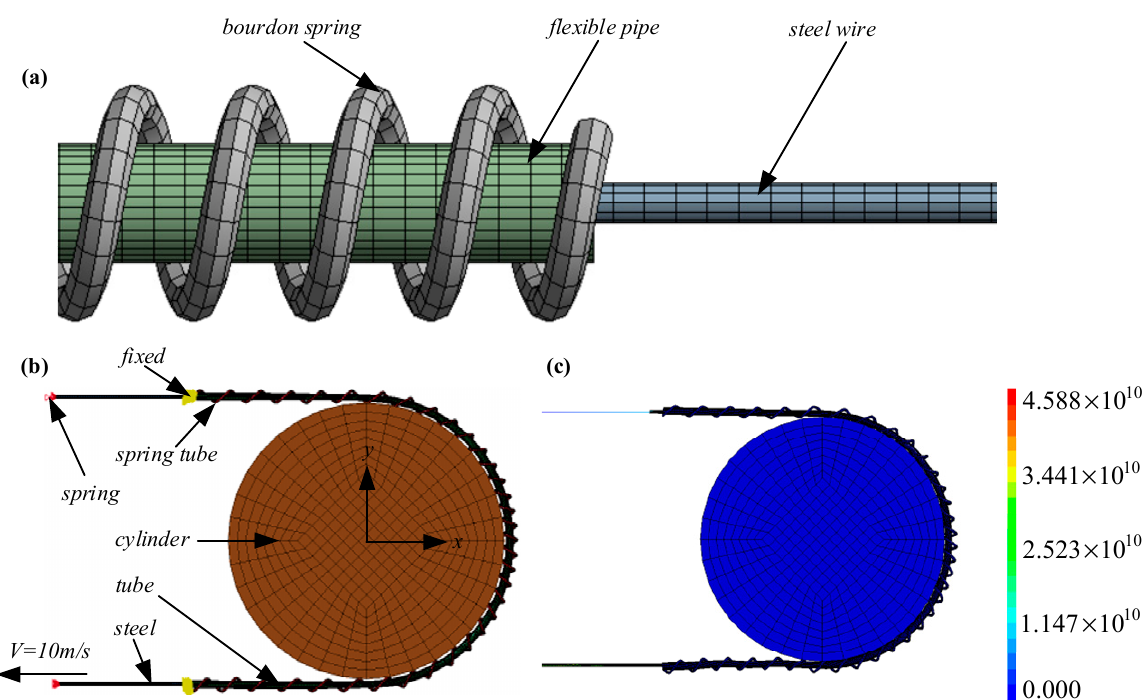
Figure 6. Lasso simulation modeling analysis diagram. ( a ) Grid division diagram; ( b ) K file model; ( c ) Dynamic equivalent stress cloud chart.